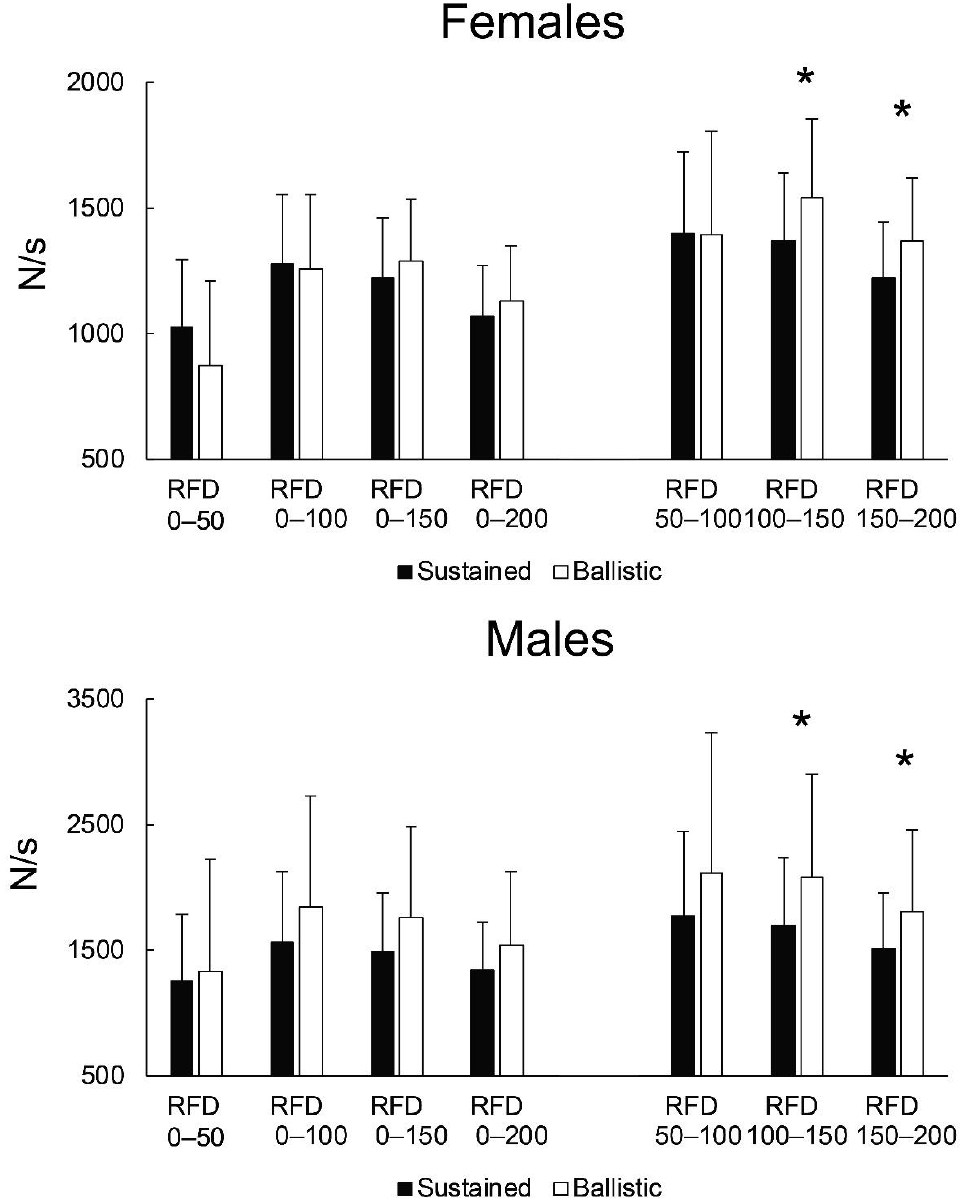
Figure 2. Comparison of RFD outcomes between explosive sustained and pulse contractions for the ankle extension task across time intervals for females ( top graph ) and males ( bottom graph ). * indicates statistically significant pair-wise comparison.